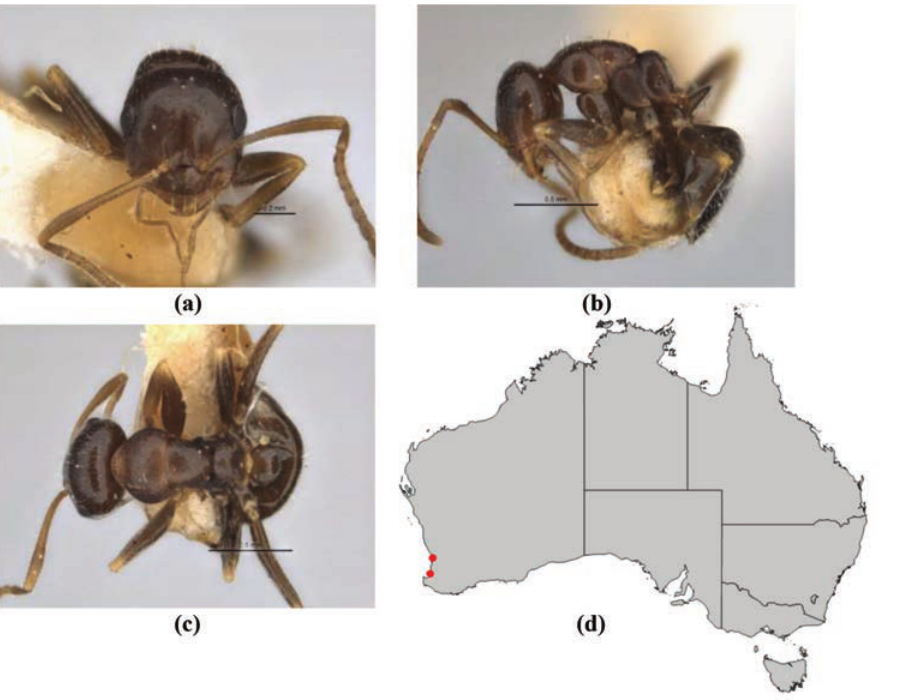
Figure 46. Melophorus propebiroi sp. n.: minor worker holotype (JDM32-001947) frons ( a ), profile ( b ) and dorsum ( c ); distribution map for the species ( d ). Low resolution scale bars: 0.5 mm ( b, c ); 0.2 mm ( a ). distinct striolae on metapleuron; propodeum angulate, propodeal angle blunt; length ratio of propodeal dorsum to its declivity greater than 1:2; erect propodeal setae always absent; appressed propodeal setulae long and closely aligned, creating pubescence; prop- odeal spiracle situated on or beside declivitous face of propodeum, and longer (length ≥ 0.50 × height of propodeum). Petiole . In profile, petiolar node squamiform; in full-face view, shape of petiolar node tapered with squared-off vertex; node shining and distinctly microreticulate. Gaster . Gaster shining with superficial microreticulation; pilosity of first gastral tergite consisting of well-spaced, short, thick, erect setae over long, closely aligned, whitish, appressed setae. General characters . Colour concolorous